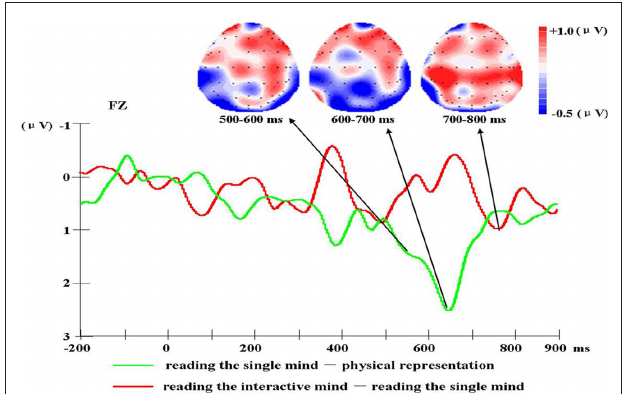
FIgure 3 | The mean amplitude difference between conditions (physical representation subtracted from reading the single mind and reading the single mind subtracted from reading the interactive mind) at the Fz site, as well as the corresponding scalp topographies (physical representation subtracted from reading the single mind in the 500- to 600 and 600- to 700-ms epoch and reading the single mind subtracted from reading the interactive mind in the 700- to 800-ms